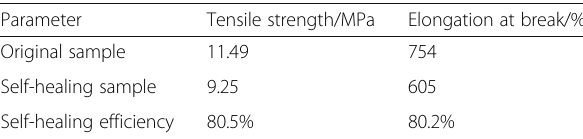
Table 1 mechanical properties variation of polyurethane film before and self-healing